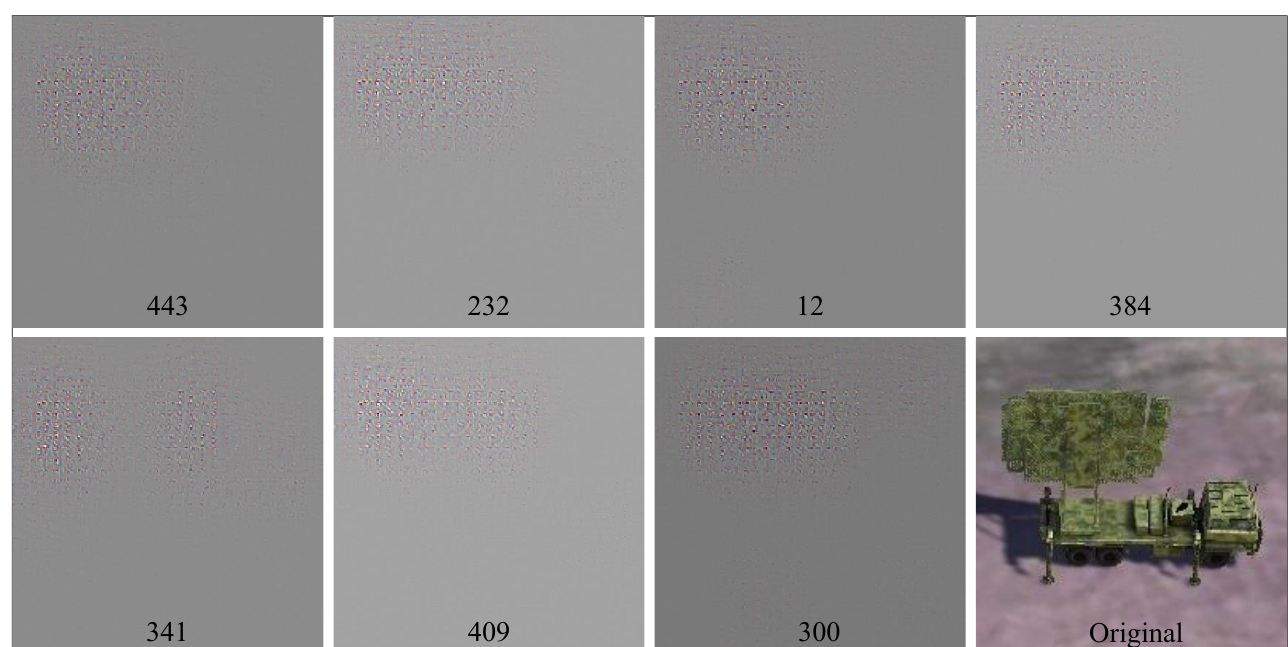
Figure 10. Visualization of the extracted features by the radar antenna clustered convolution